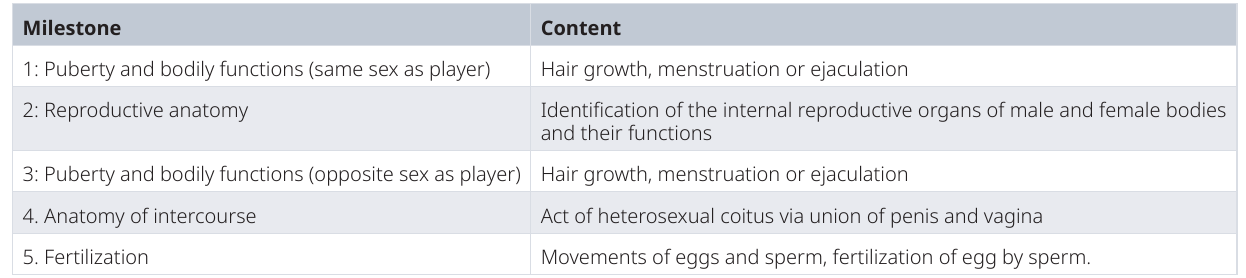
Table 1. Key educational content for each milestone in the MFF game. Milestone